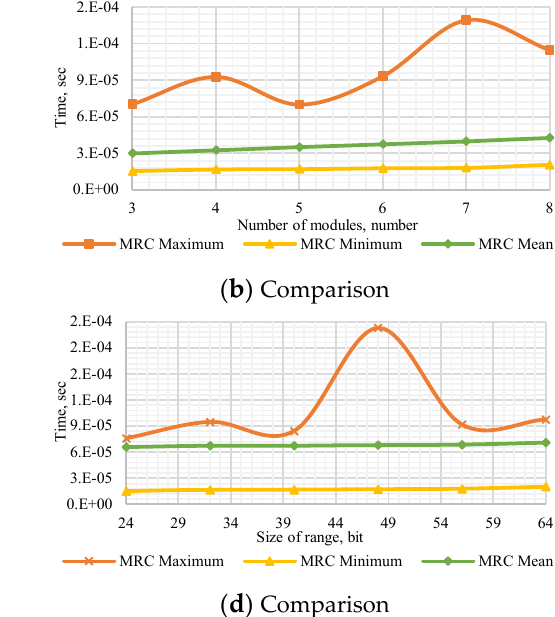
Figure A2. Performance of MRC method to ( a ) determine the number’s sign with a dynamic number of modules p , ( b ) compare dynamic number of modules p , ( c ) determine the number’s sign with a dynamic bit width, and ( d ) compare numbers with dynamic bit width.